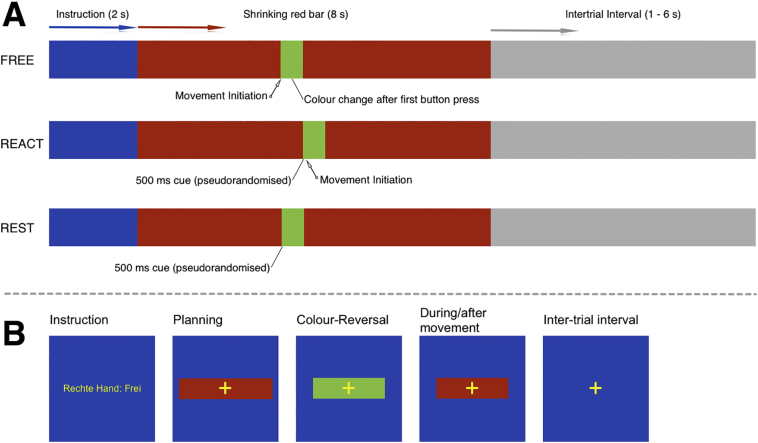
Experimental paradigm.(A) Schematic representation of the experimental paradigm (trial). FREE condition (upper line), movement onset triggers the color change in the visual stimuli (i.e. red bar to green cue). REACT condition (middle line), movement initiation is delayed with respect to the green visual cue. REST condition (lower bar), has no movement although the visual stimuli changes at pseudo randomized intervals in order to provide visual stimuli similar to FREE and REACT. (B) An example of how the different phases appeared visually to the participant.